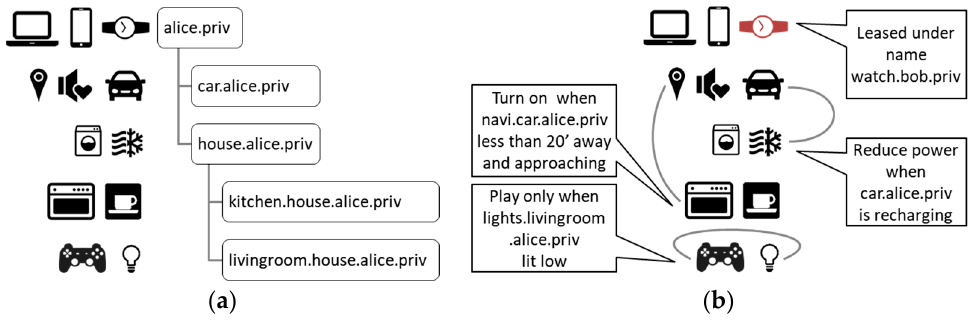
Figure 6. ( a ) Hierarchical device organization by DNS naming; ( b ) Introducing custom relationships by annotations in DNS TXT resource records. by annotations in DNS TXT resource